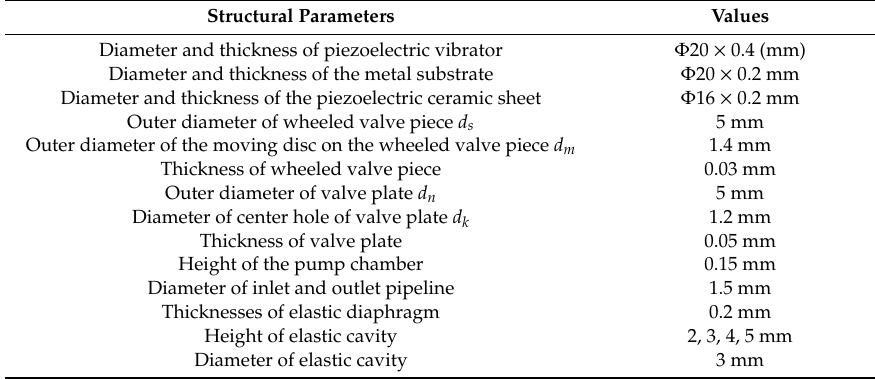
Figure 12. Structure of the wheeled check valve; ( a ) wheeled valve piece; ( b ) valve plate. Piezoelectric ceramic sheet